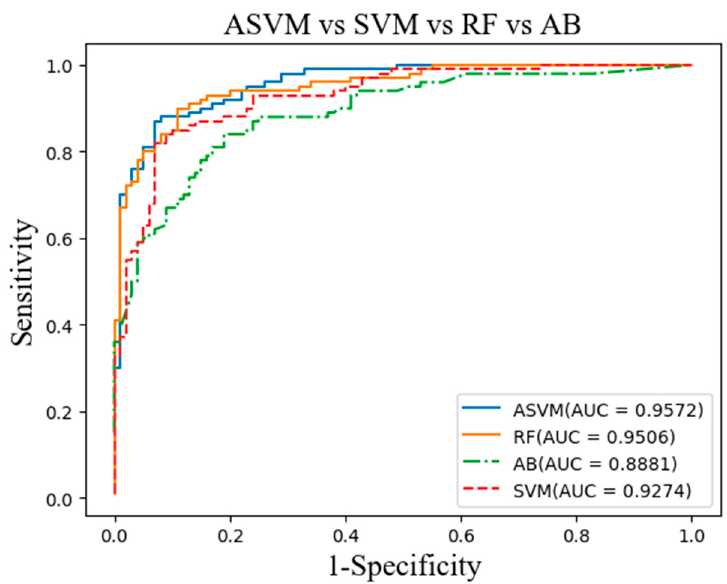
Figure 5. Distributions of three ROC algorithms.